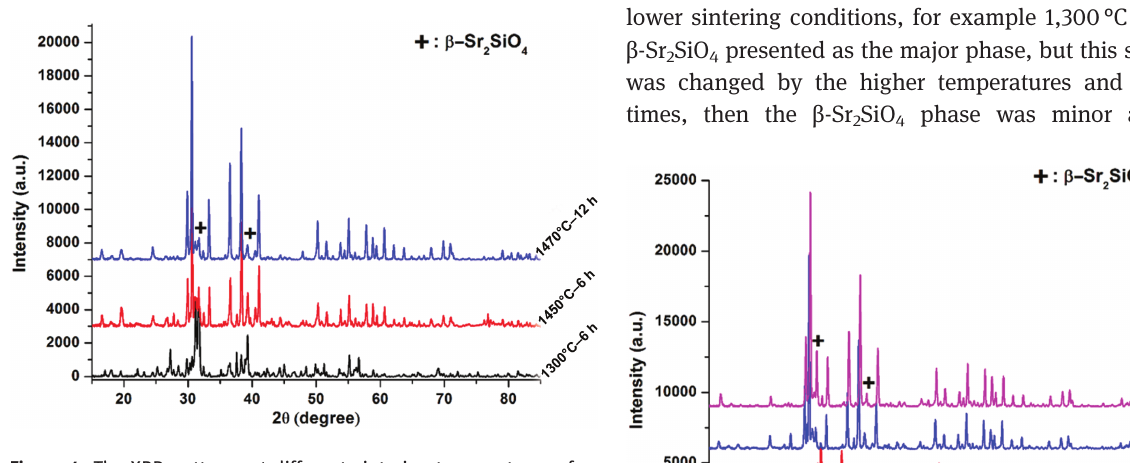
Figure 4: The XRD patterns at different sintering temperatures of Sr 3 SiO 5 :Eu 3+ , Dy 3+ .